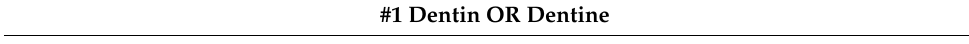
#2 Bonding OR Bond OR Bonding efficacy OR Dental bonding OR bond strength OR bonding effectiveness OR Bonding performance OR Bond performance OR adhesive #2 properties OR Micro-tensile strength OR microtensile strength OR Microtensile bond strength OR bonding properties OR microshear bond strength OR shear bond strength OR performance #3 double-application coat OR double-application time OR Bonding application time OR Time factors, working time OR adhesive dental coating OR rubbing OR agitation OR scrubbing OR application mode OR double application OR single application OR Double-layer application OR adhesive layer OR ultrasonic OR agitation OR vibration OR ultrasonics OR application time OR Double application technique OR adhesive dental